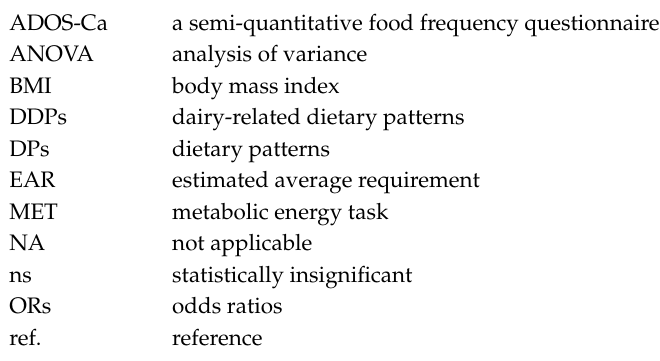
Table S1: Crude odds ratio (95% confidence interval) of prevalence abnormal body weight and composition according to dairy-related dietary patterns and calcium intake, Table S2: Correlation coefficients (r) between mothers’ and daughters’ body weight and composition